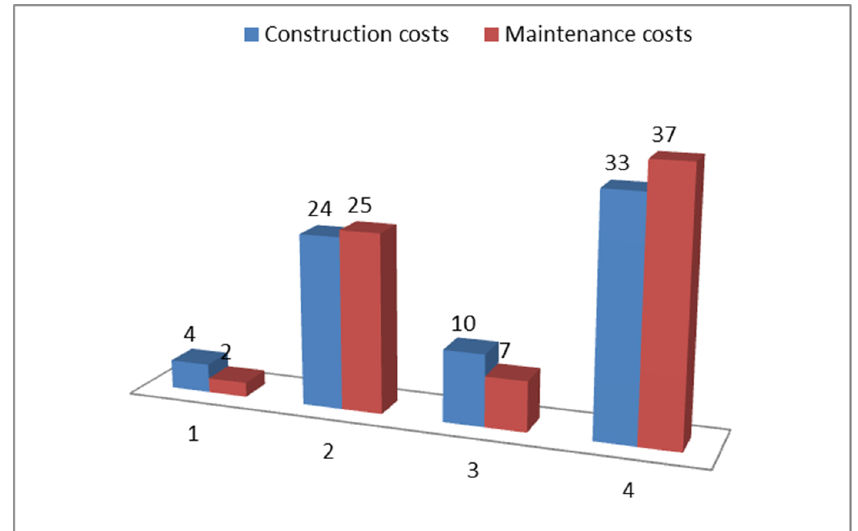
Figure 7. Box-plot for the utility of WrGIs/SuDSs perceived by stakeholders on a Likert scale from 1 (very low) to 7 (very high): HR (flood risk control), EC (erosion control), WS (water storage), PC (pollution control), ER (environmental restoration), RV (recreational value), EE (economic efficiency).